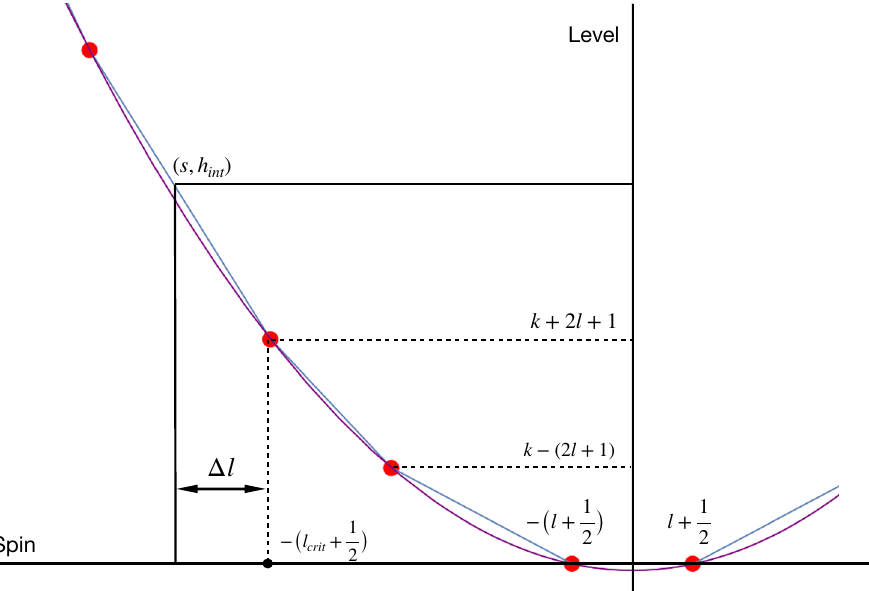
Figure 2 . We drew the left quadrant of the weight diagram of an irreducible supersymmetric su (2) current algebra module. The weight diagram is bounded by the blue line segments which are circumscribed by a the purple parabola. Spectral flowed ground states (in red) are the only states that lie on the